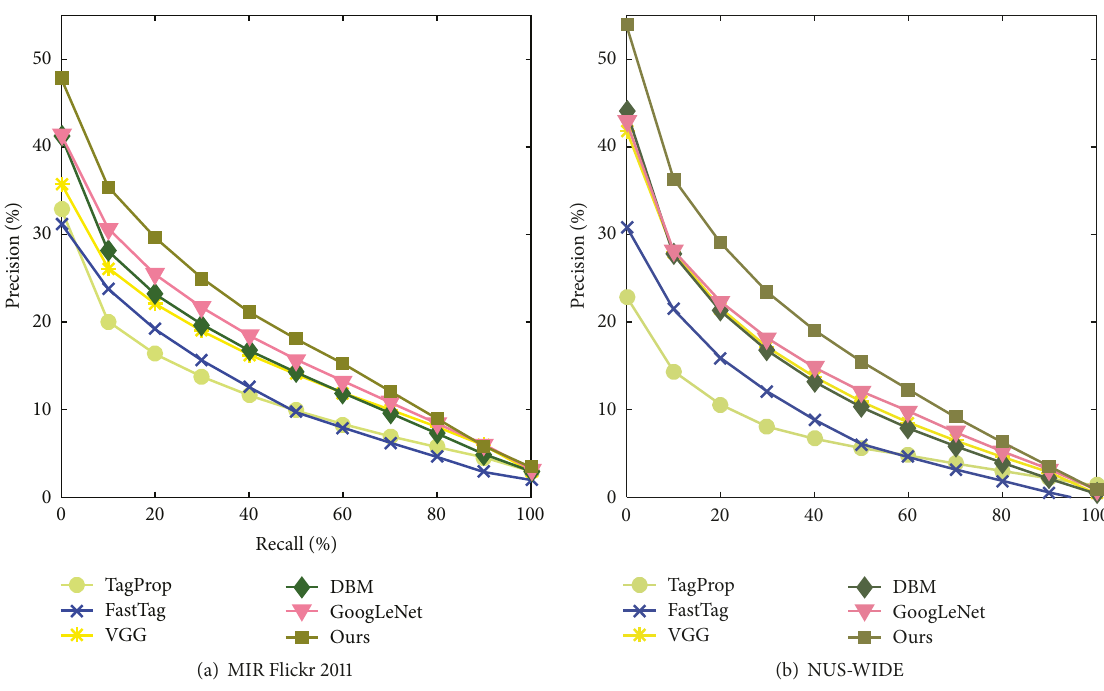
Figure 3: The PR curves on two